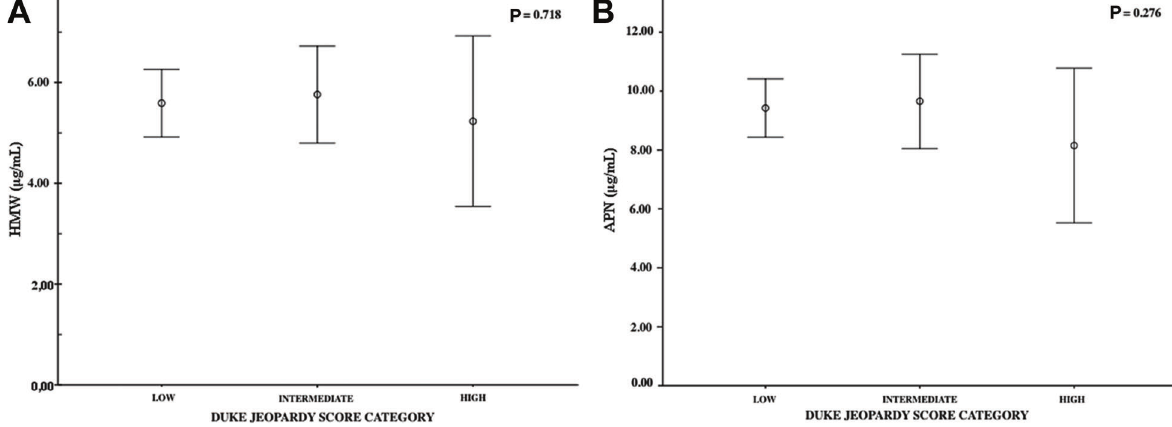
Figure 2. Association of high molecular weight (HMW) adiponectin (APN) ( A ) and APN ( B ) levels with Duke Jeopardy Score. Data are reported as means ± SD